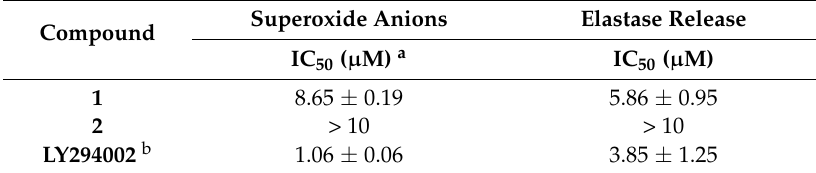
Table 3. Inhibitory effects of sterols 1 and 2 on superoxide anion generation and elastase release